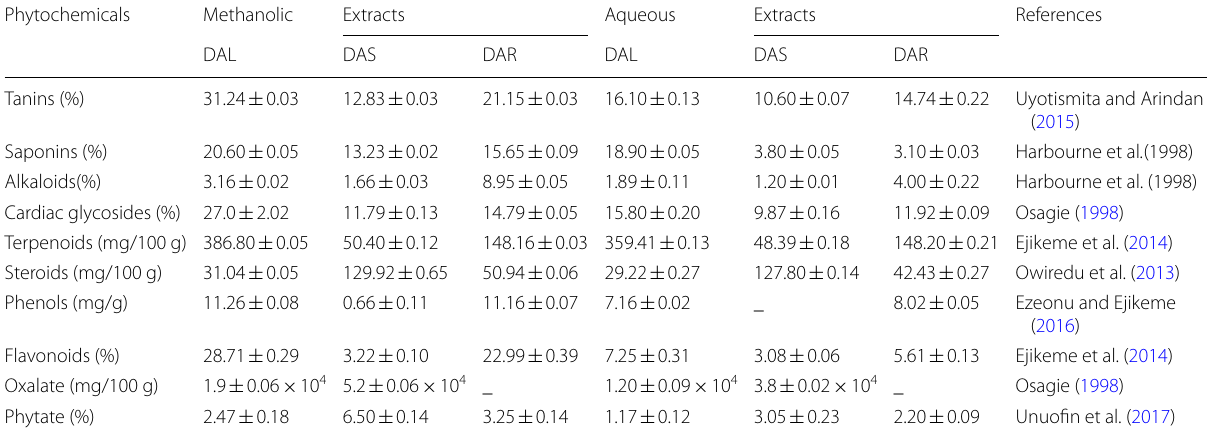
Table 8 Quantitative determination of phytochemicals in the methanolic and aqueous extracts of the roots, leaves, and stems of Dictyandra